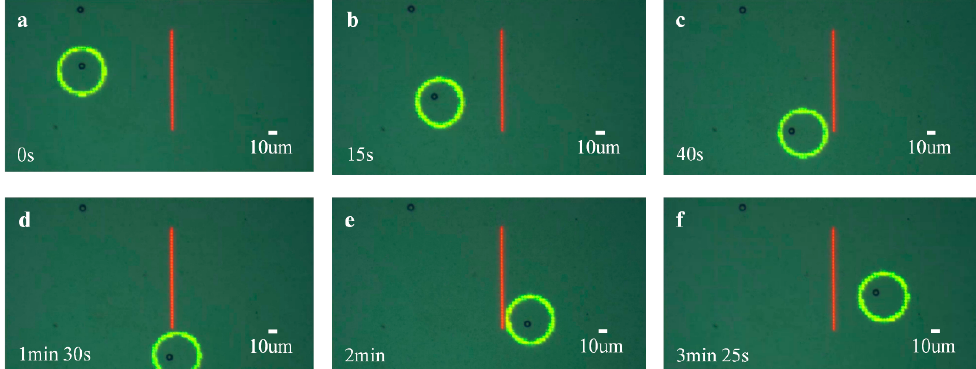
Figure 9. Diagrams of the manipulation process for obstacle avoidance. The red linear grating denotes the obstacle, and the green circle is the annular optical pattern. ( a – f ) are the real-time status of automatic manipulation in chronological order.